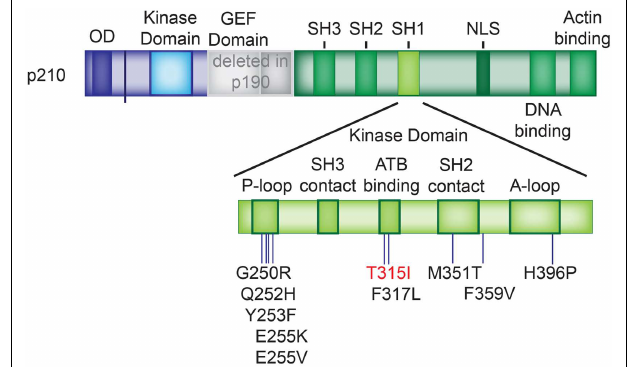
FIGURE 5 | BCR–ABL1TKD mutations . Location of the BCR–ABL1 tyrosine kinase domain mutations listed in Table 2 .TheT315I mutation, which causes resistance against imatinib, dasatinib, and nilotinib is depicted in red. P-loop: phosphate-binding loop; A-loop: activation